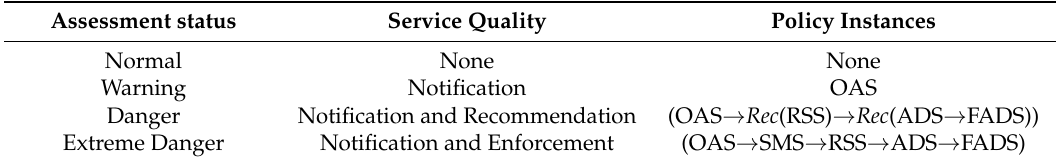
Table 4. Typical policies